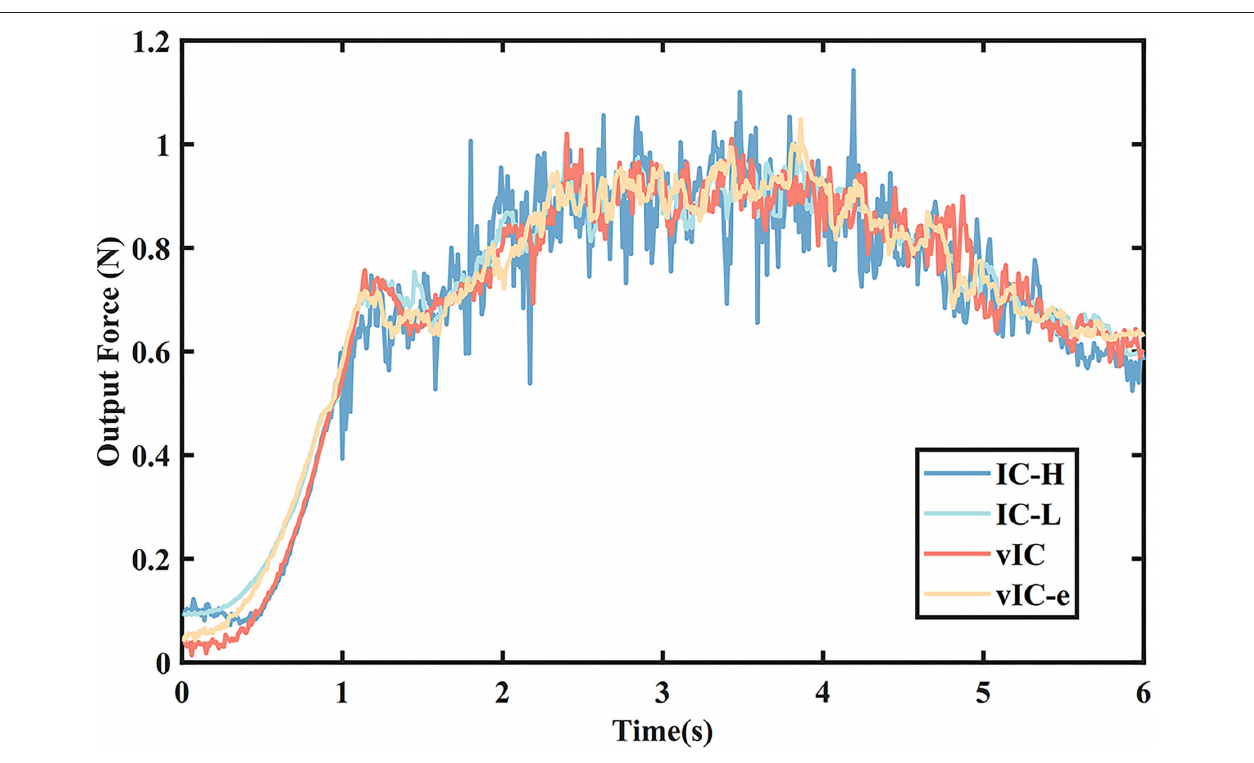
FIGURE 8 | The mean output force of four control algorithms during a rightward